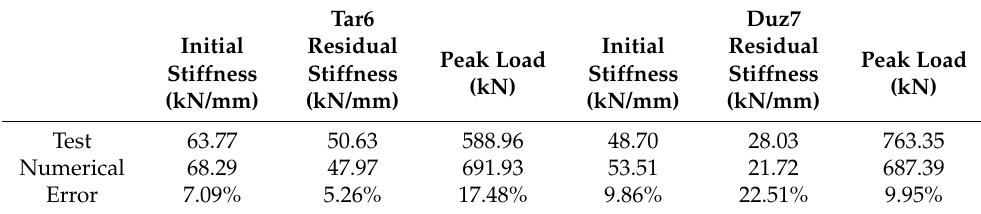
Figure 6. Time history curve of the base shear force for the Tar6 case. Table 2. Comparison of numerical and test results.